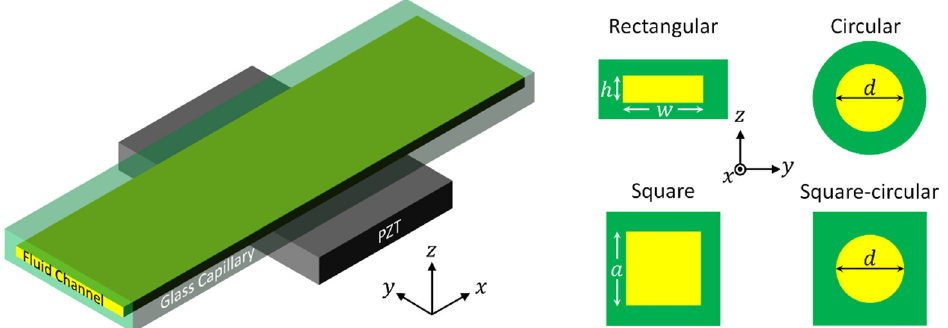
Figure 1. Schematic presentation of a typical glass capillary-based ultrasonic particle manipulation device, which mainly consists of an ultrasonic transducer (here PZT) and a glass capillary. The common cross-sections of glass capillaries designed for ultrasonic particle manipulation are schematically shown on the right side, where square-circular indicates glass capillaries whose outer and inner cross-sections are square and circular, respectively.